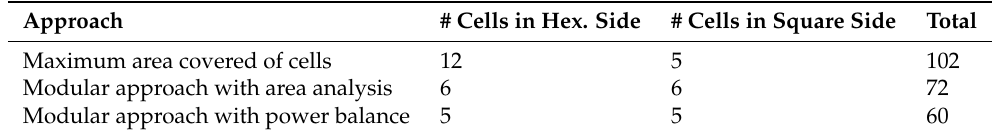
Table 4. Comparison of the number of cells for three design approaches: maximum area approach vs. modular approach with area analysis and power